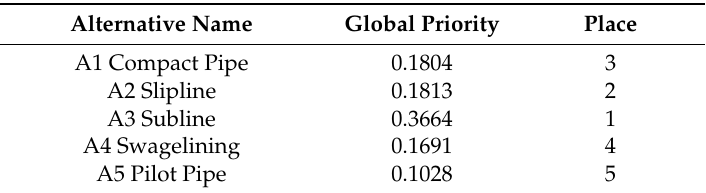
Table 8. Alternative